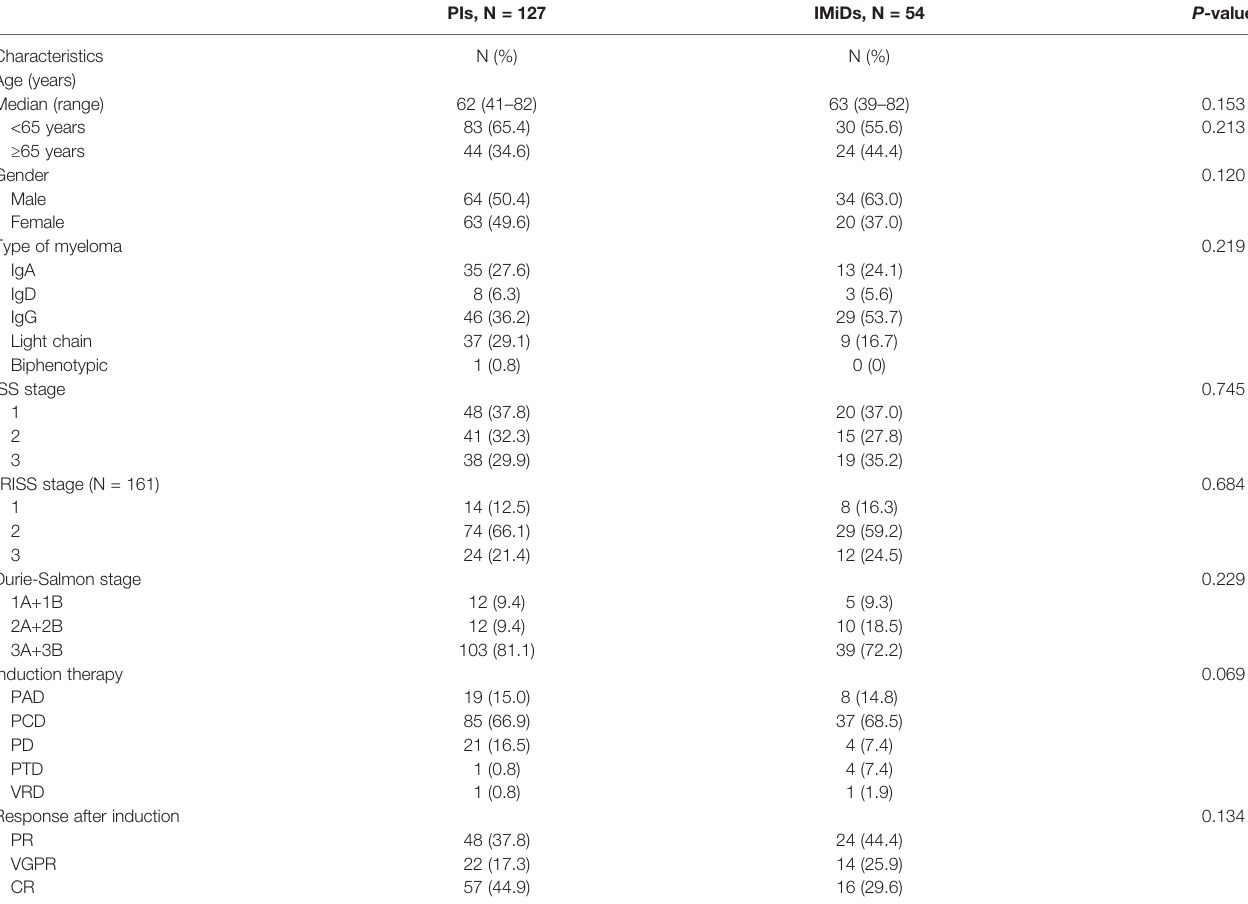
TABLE 2 | Baseline characteristics of NDMM patients who received maintenance therapy of proteasome inhibitors or immunomodulators. PIs, N =